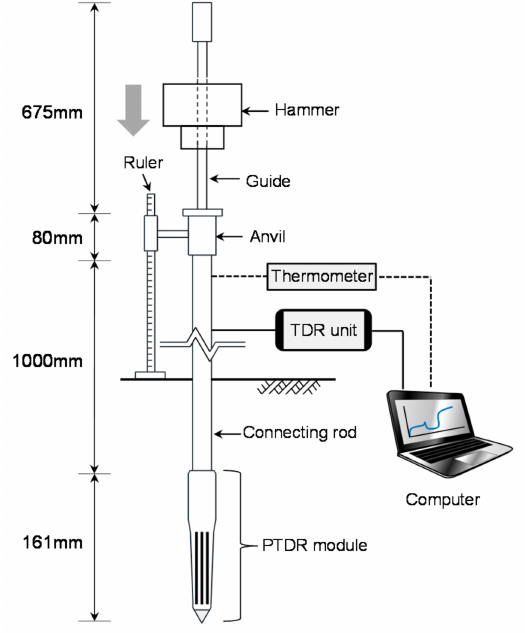
Figure 1. Schematic drawing of PTDR connected to the measurement system.